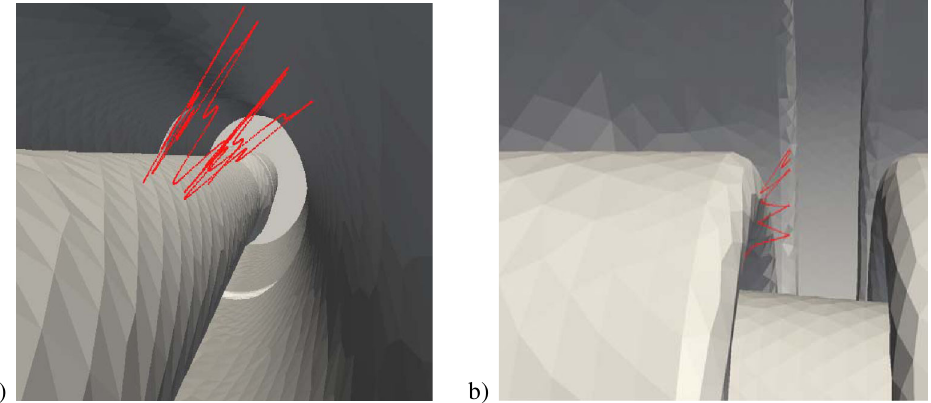
FIG. 13. Multipacting at 110 kW in the coaxial line (a) and between the window and choke at 60 kW (b).